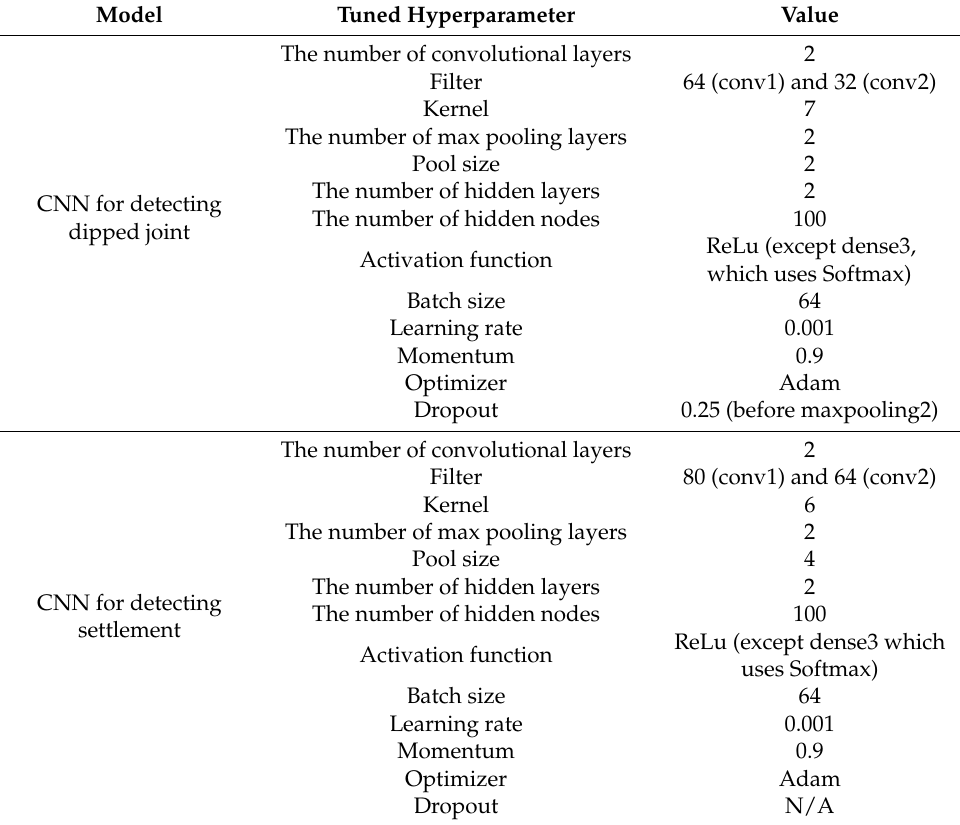
Table 8. List of tuned hyperparameters for detecting combined detects in the second